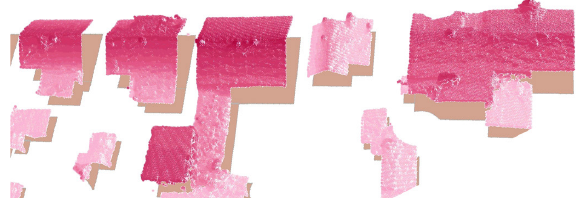
Figure 4. 3D view of obstacles point cloud